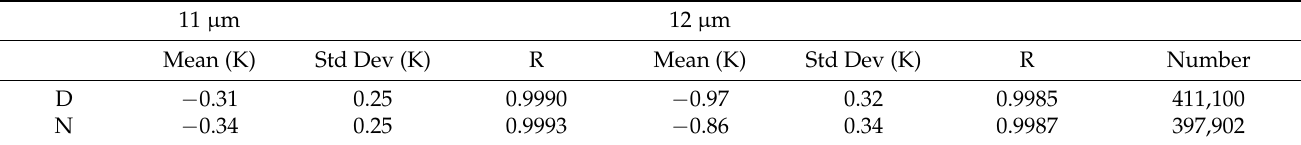
Table 4. Difference of VIRR_COR and MODIS_BT (D means daytime, N means nighttime, R means correlation coefficient).